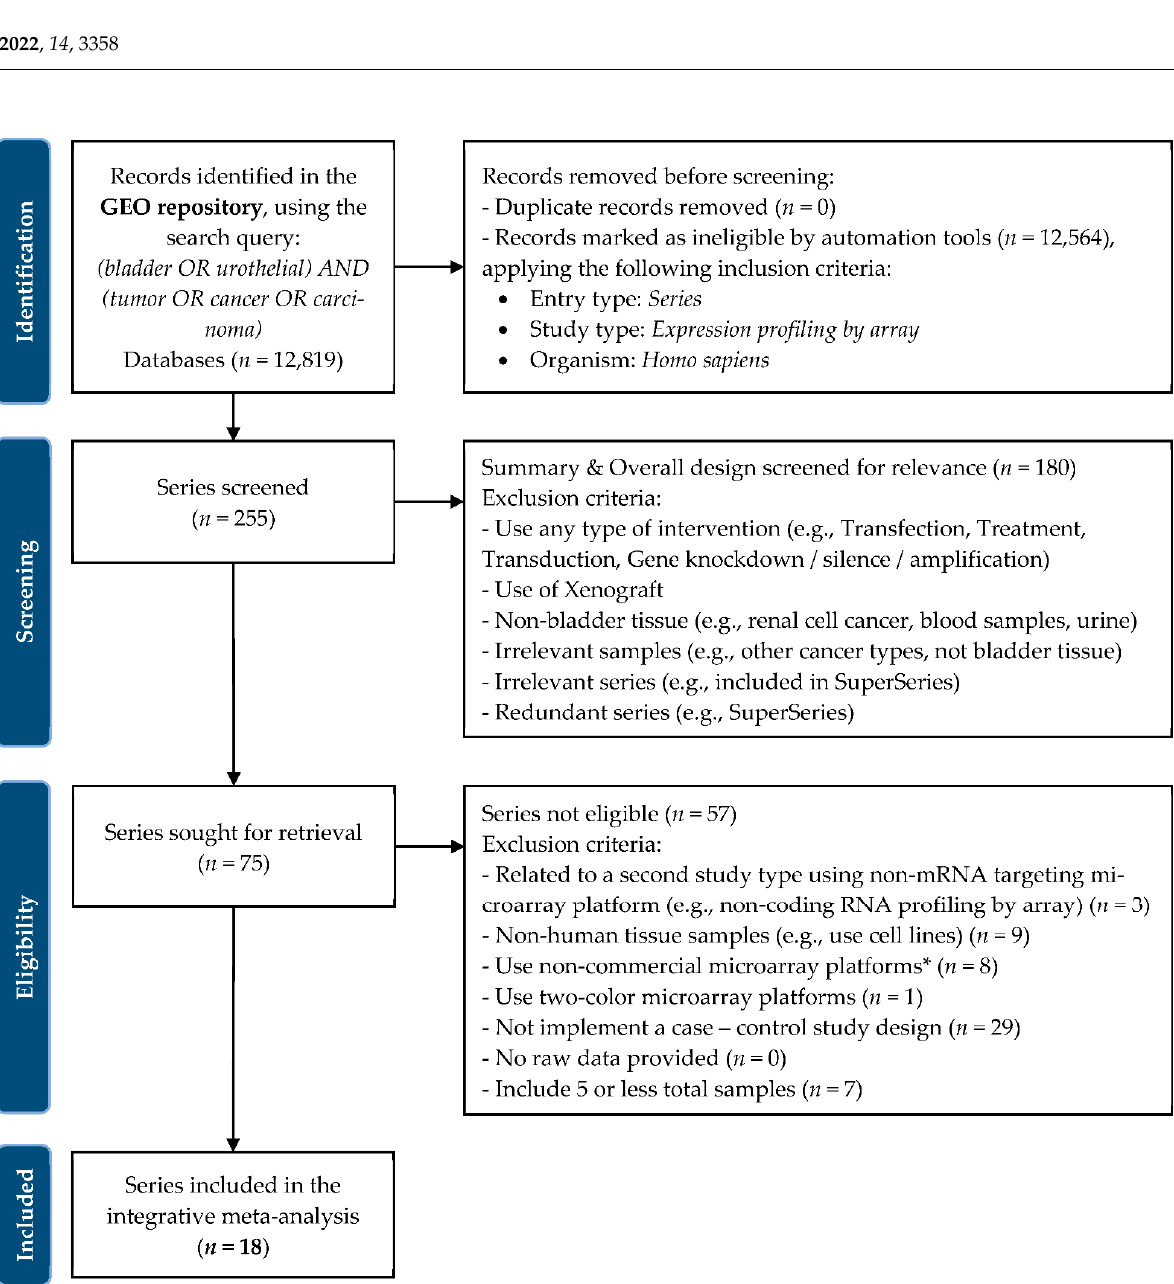
Figure 2. Preferred reporting items for systematic reviews and meta-analyses (PRISMA 2020) flow diagram. * An array identical to a commercial platform in which a custom, remapped CDF environment is used to extract data, was considered as a commercial platform.